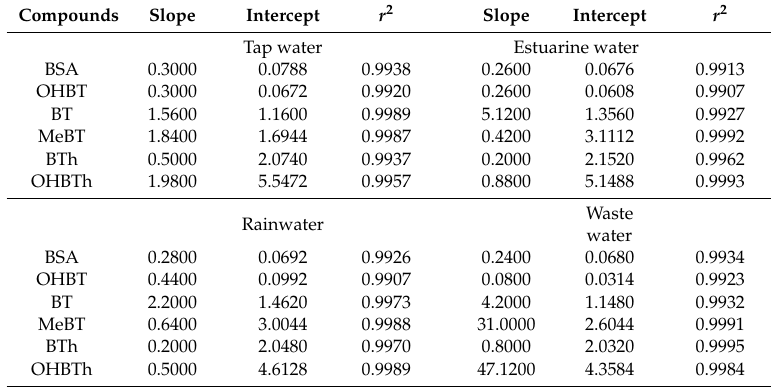
Table 3. Calibration parameters, including r 2 , for the four real water samples spiked between 25.0 and 100.0 µ g L − 1 and obtained for BSA, OHBT, BT, MeBT, BTh, and OHBTh chemicals by BA µ E(R, 12.5% / CN1, 87.5%)- µ LD / HPLC-DAD through the standard addition method (SAM) approach under optimized experimental